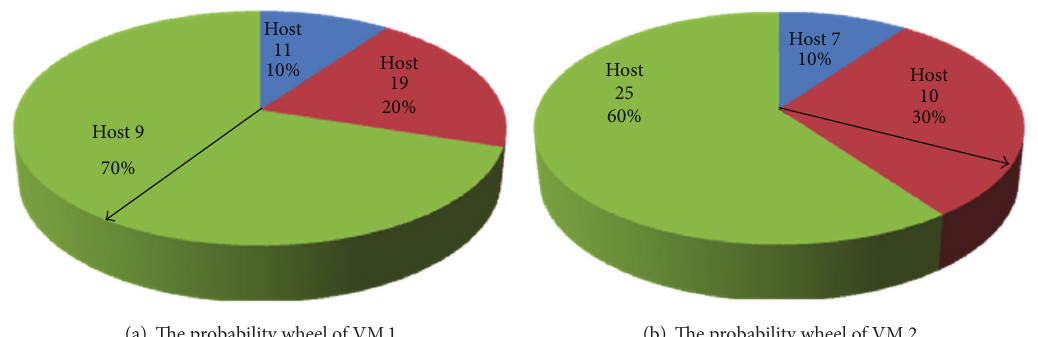
Figure 5: Examples of the probability